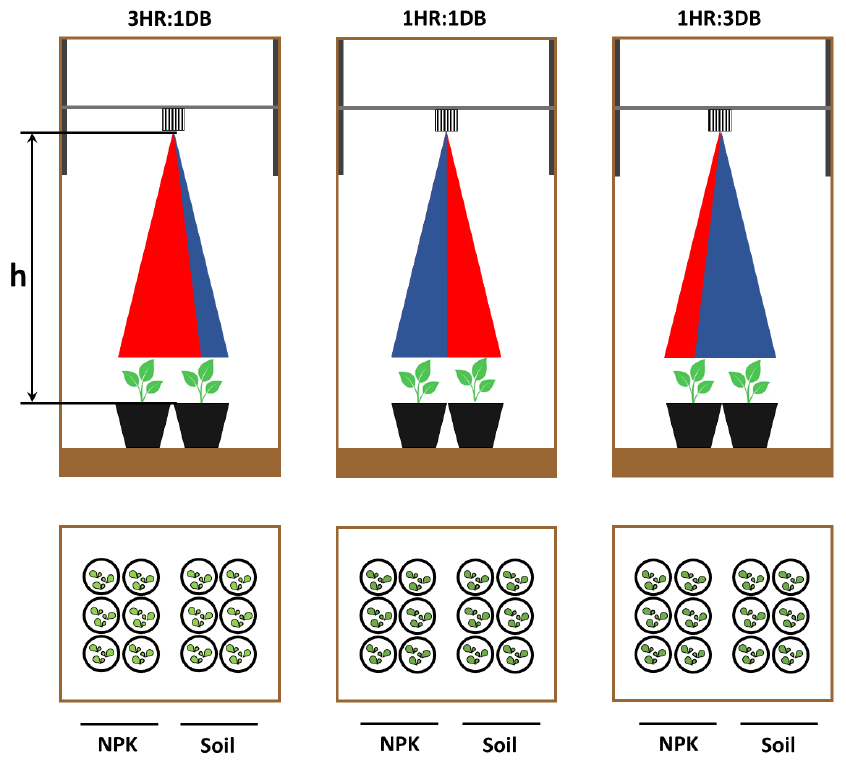
Figure 2. Simplified sketch of the experimental setup: front view ( top ) and top view ( bottom ).